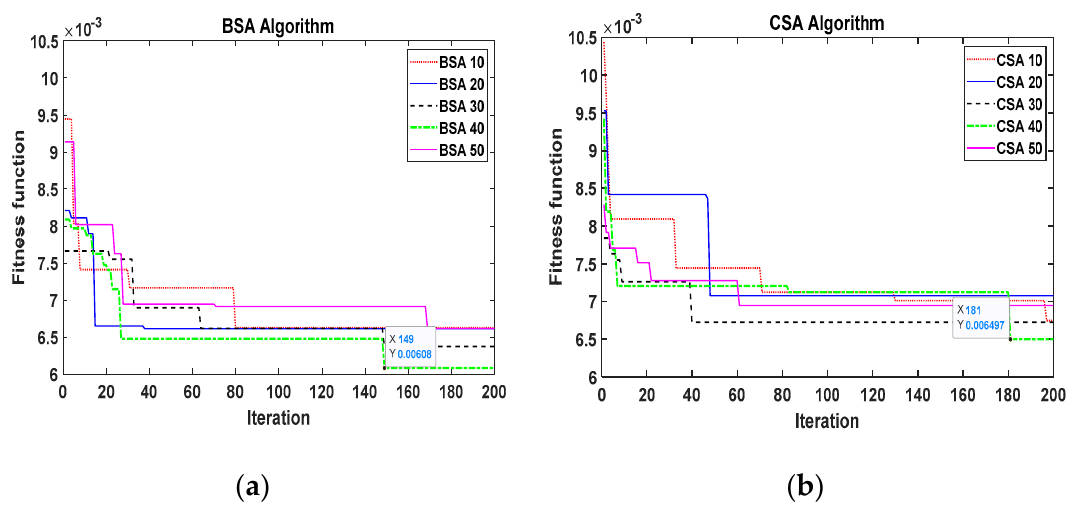
Figure 5. Metaheuristic algorithms simulation for five population size; ( a ) BSA; ( b ) CSA.